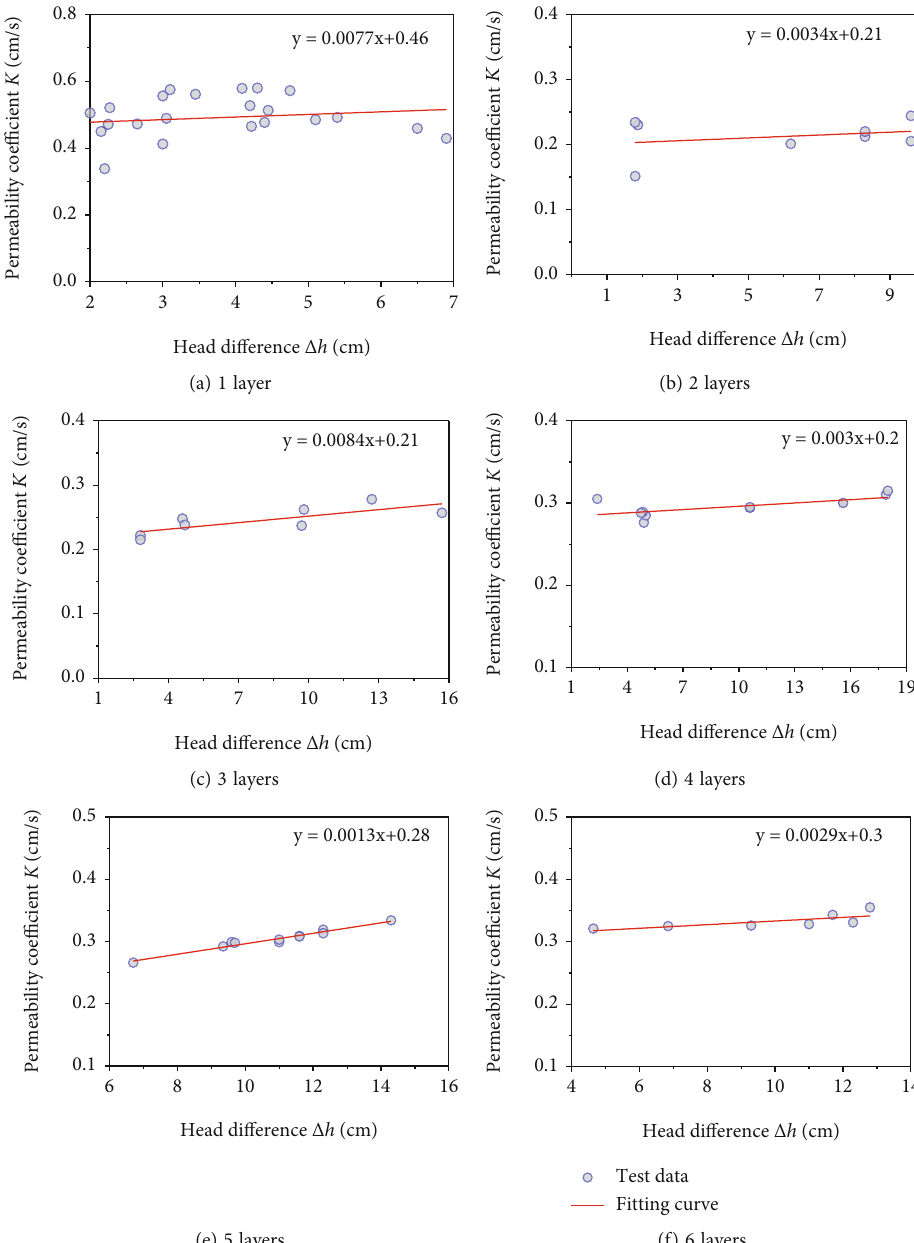
Figure 8: Variation of the permeability coe ffi cient of the slotted tube overlay geotextile with water head di ff